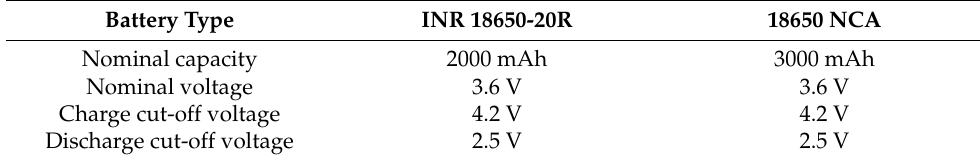
Table 1. Main specifications of different batteries.